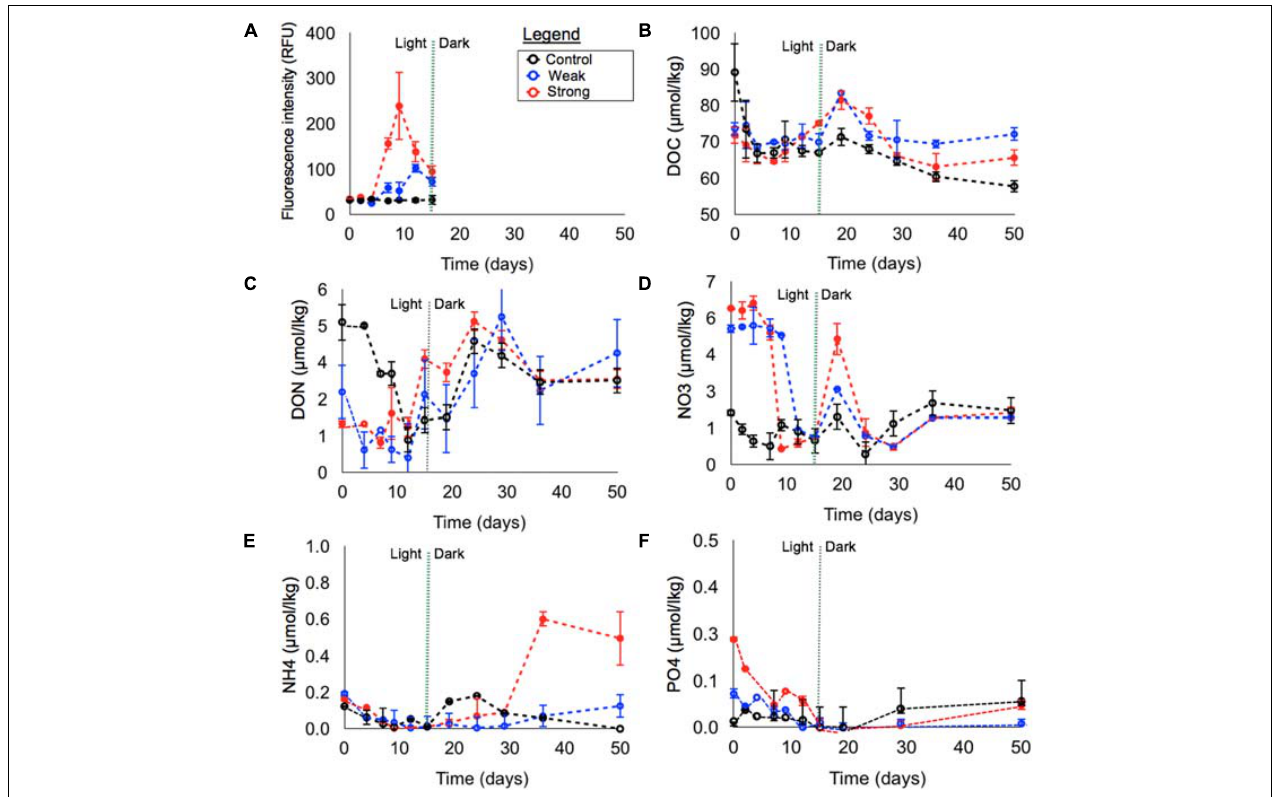
FIGURE 3 | Variation in concentrations versus time in light and subsequent dark incubations, separated by vertical dashed lines. Fluorescence intensity (RFU) (A) , DOC (B) , DON (C) , NO 3 − (D) , NH 4 + (E) , and PO 4 − 3 (F) . Error bars are ± 1 S.D. from